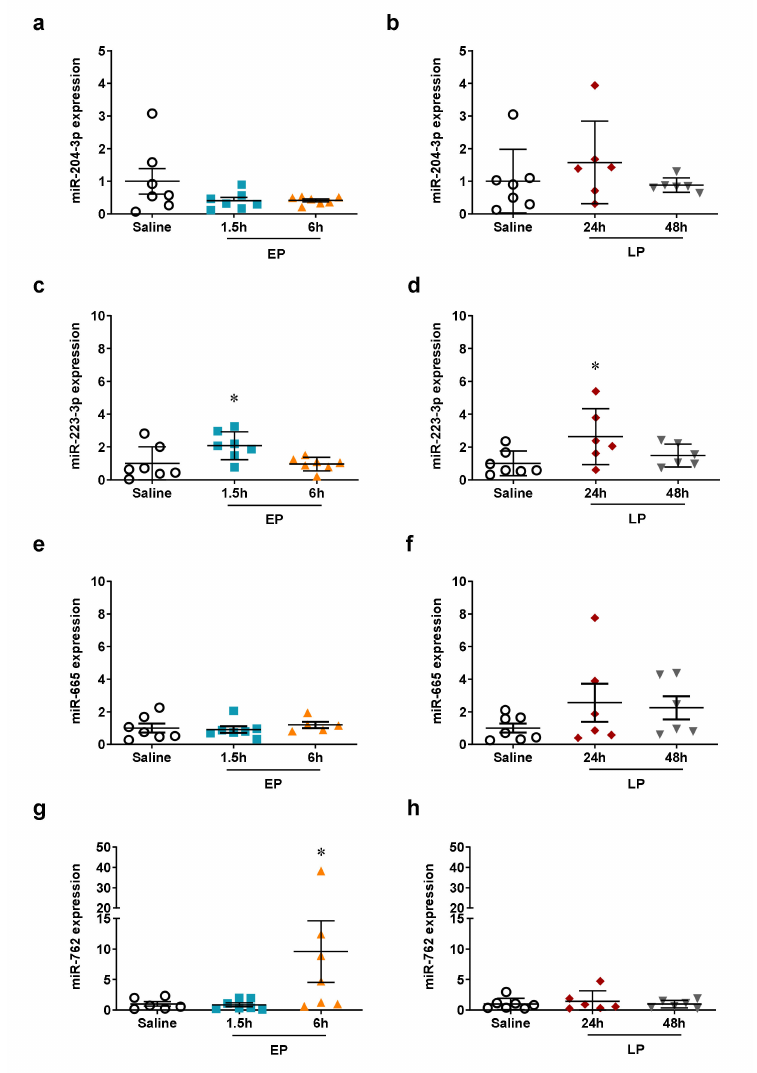
Figure4. qPCRvalidationofmiRNAsupregulatedduringtheearlyphaseonthemicroarray. Therelative expression of miRNAs normalized to let-7g-5p (fold changes vs. saline). Left column: EP, right column: LP. ( a , b ) miR-204-3p; ( c , d ) miR-223-3p; ( e , f ) miR-665; ( g , h ) miR-762. Data are expressed as mean ± SEM; one-way ANOVA; *: p <